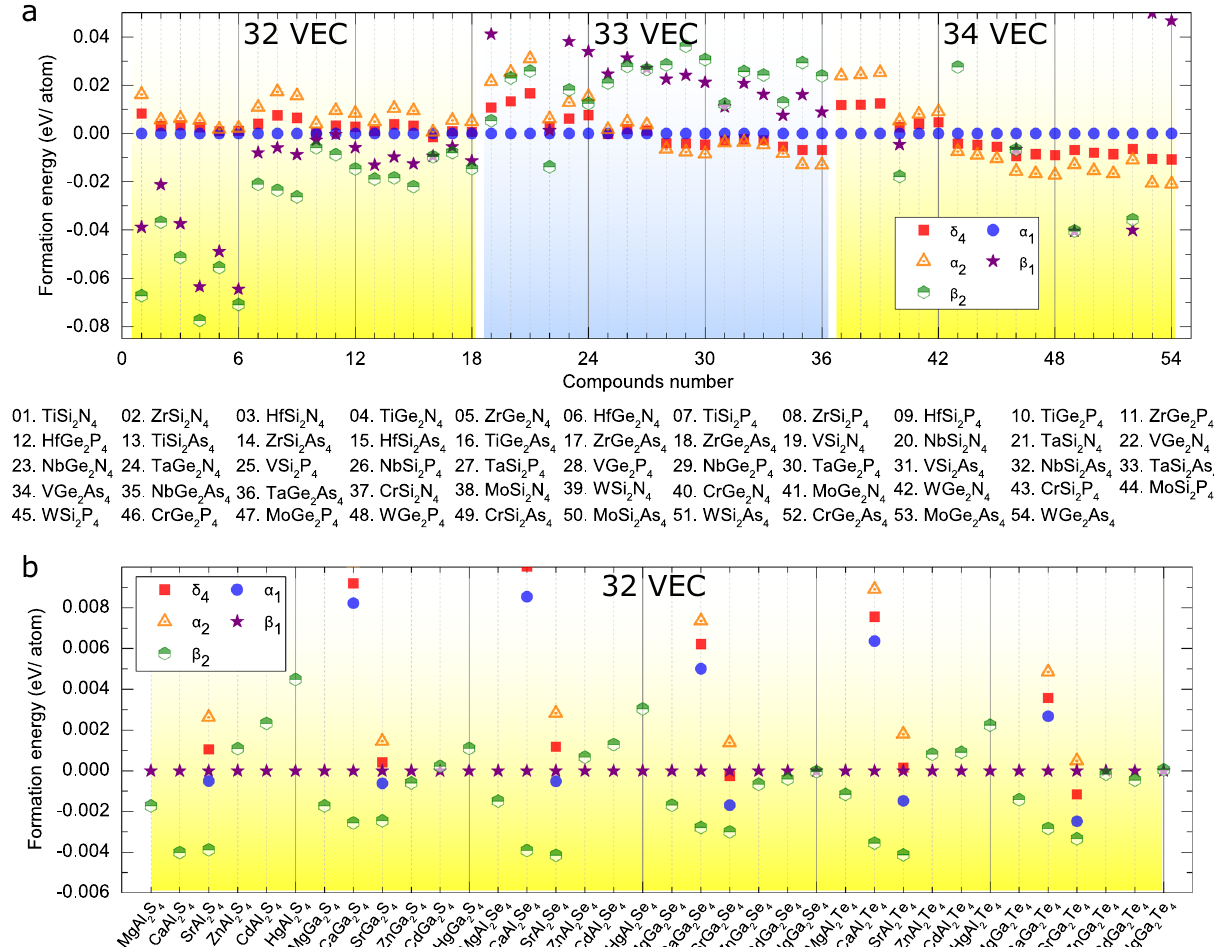
Fig. 2 DFT-derived enthalpies of formation of MA 2 Z 4 monolayers. Here, we only show the data for the fi ve lowest-energy con fi gurations. a and b are for M being the fi rst transition-metal group elements and alkali-earth elements, respectively. In a , b , the enthalpies for each compound are relative to the total energies of the α 1 and β 1 structures, respectively. Note that VEC is the number of valence electrons for one chemical formula. For more details about enthalpies of formation refer to Supplementary Tables 2 –